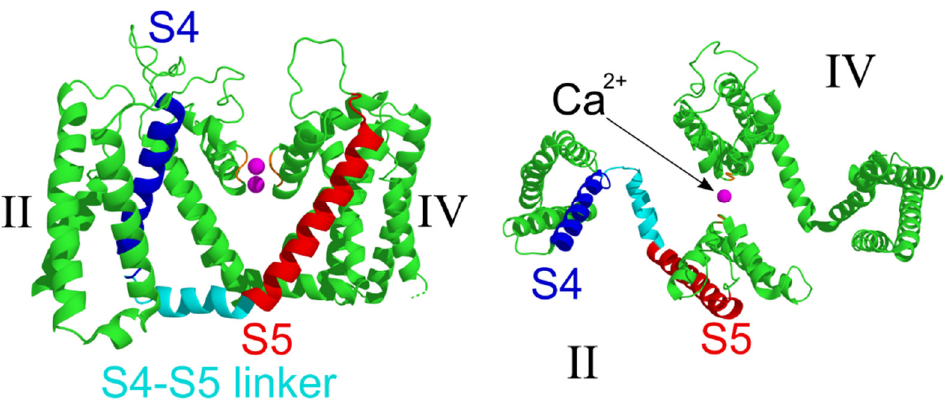
Figure 6. Structural modelling of Cav2.1 channels. Side view of the homology model of the domains II and IV of the alpha subunit (left). The front and back domains were removed for clarity. The crystal structure of the rabbit Cav1.1 alpha subunit (accession code: 5gjw) was used to show the corresponding structures that are affected by the mutation identified in the patient’s Cav2.1 channel. The relevant helices are highlighted using different colors: S4 (blue), S4–S5 linker (cyan), and S5 (red). On the right-hand side is the top view of the channel to further show the structural and functional relationships between the S4–S5 linker and the voltage-sensor S4, as well as the S5 and the ion conducting pore. The magenta spheres represent the Ca 2+ ions located within the selectivity filter. Roman numbers mark the corresponding domains.